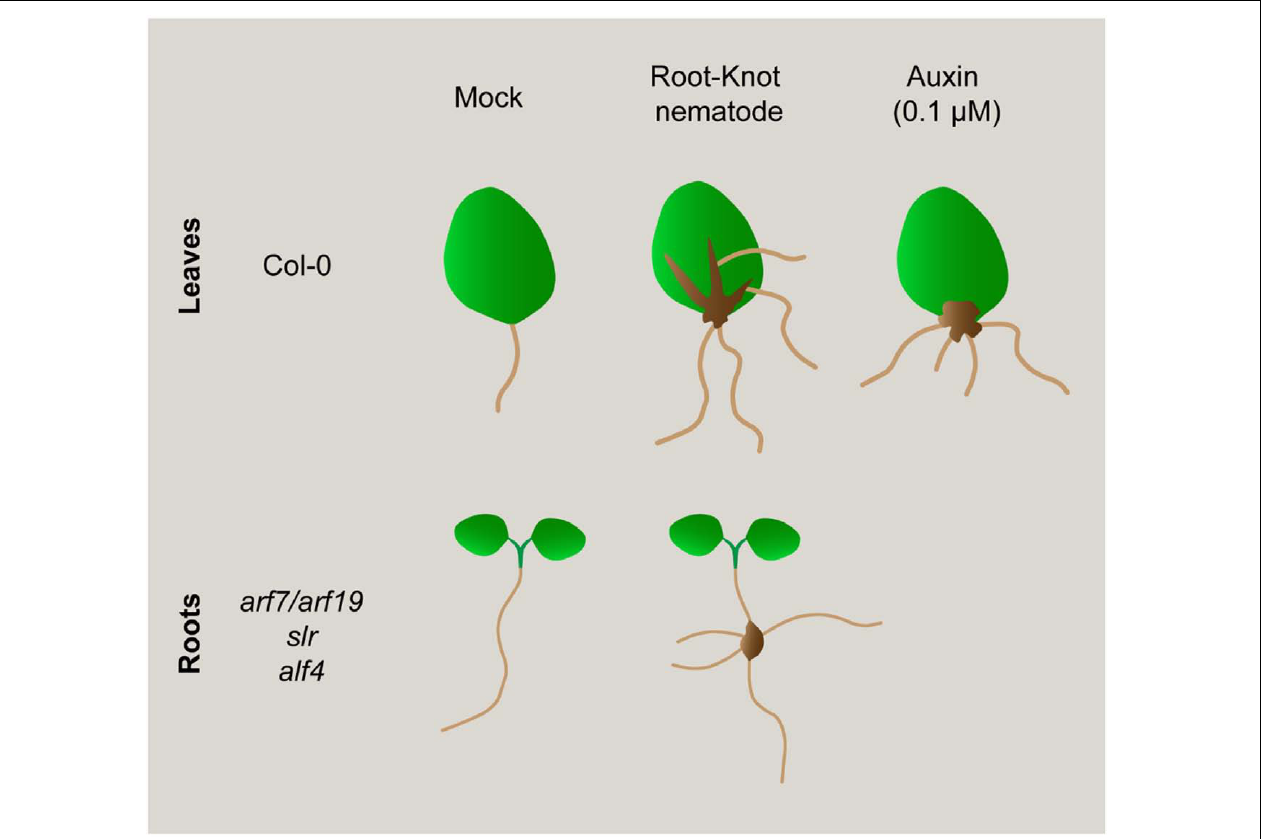
FIGURE 7 | Schematic representation of morphogenic processes induced in leaves after different treatments: Exogenous auxin induced roots and infection with a RKN. Nematodes induce new root formation (ARs) from callus-like structures in the primary veins of leaves, similar to what happen from callus induced after exogenous auxin treatment. However, nematode induced callus-like also develop ARs from secondary veins, a process that does not occur after only auxin treatment. Interestingly, non-canonical roots are also induced in root-galls from mutants severely impaired in LR formation (i.e., arf7/arf19 , slr , alf4 ). Hence, nematodes could induce new root formation in galls bypassing upstream key regulators for LR formation or by using partially different molecular